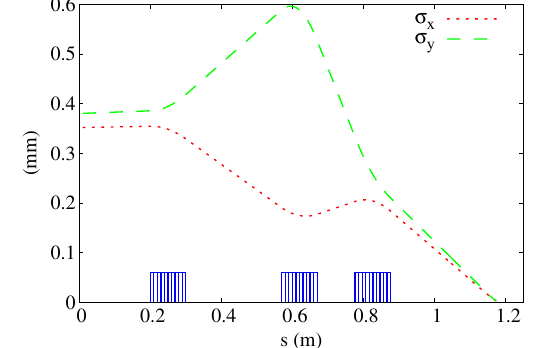
Table III. We used our new approach to compute spectra for